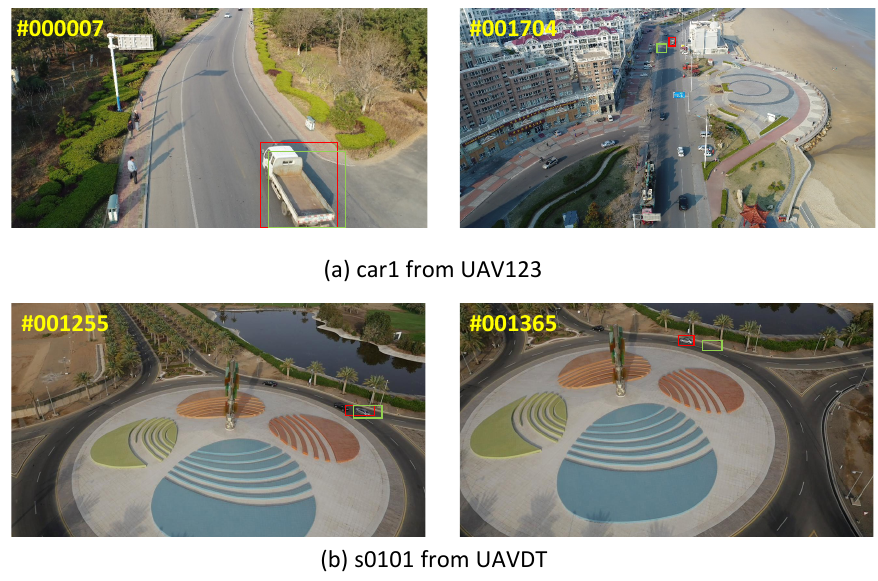
Figure 15. Two failures on sequence s0101 from UAVDT [7] and car1 from UAV123 [6]. The green box is the results of our tracker, and the ground truth is represented by the red